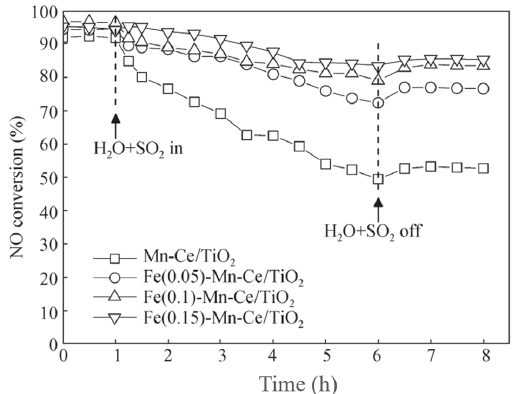
Figure 22. Effect of H 2 O and SO 2 on NO conversion over Mn–Ce/TiO 2 and Fe–Mn–Ce/TiO 2 catalysts (Reaction conditions: 0.06 vol % NO, 0.06 vol % NH 3 , 3 vol % O 2 , 3 vol % H 2 O (when used), 0.01 vol % SO 2 (when used), balance N 2 , GHSV 50,000 h − 1 , total flow rate 300 mL/min, tested at 180 °C). (Reproduced with permission from Reference [43], Copyright 2010, Science Direct.).